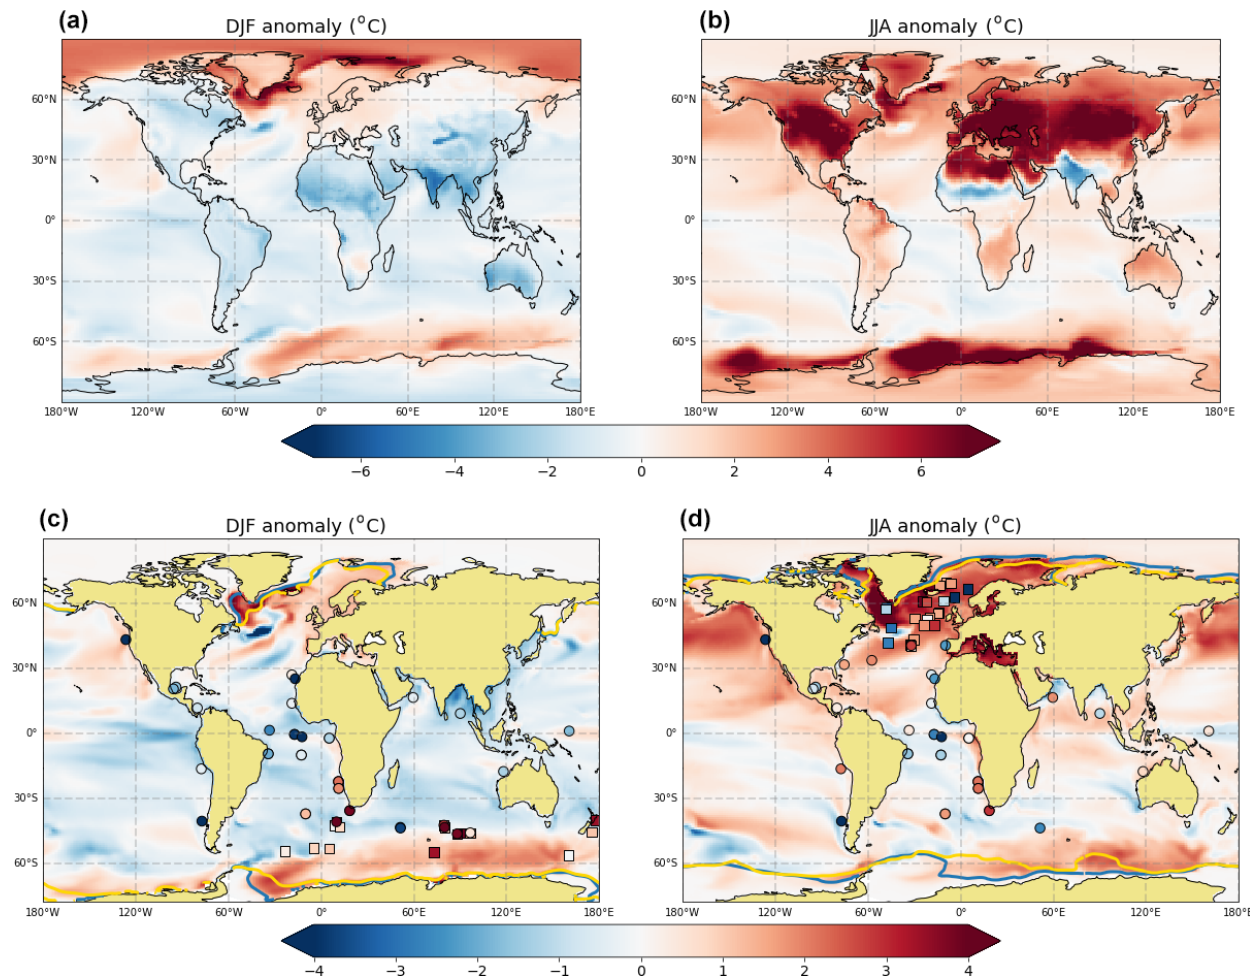
Figure 2. DJF and JJA surface temperature anomalies (LIG minus PI) with proxy data overlaid (filled markers: squares for the compilation by Capron et al., 2014, 2017; dots for the compilation by Hoffman et al., 2017; triangles for Arctic terrestrial proxies; Axford et al., 2011; Francis et al., 2006; Fréchette et al., 2006; McFarlin et al., 2018; Melles et al., 2012; Plikk et al., 2019; Salonen et al., 2018). The pre- industrial reference is 1850CE for model anomalies, 1870–1899 for Capron et al. (2014, 2017) and 1870–1889 for Hoffman et al. (2017). (a–b) Surface air temperatures. (c–d) Sea surface temperatures, with contours of sea-ice concentration at 15% overlaid in February for DJF and August for JJA (blue: LIG; yellow: